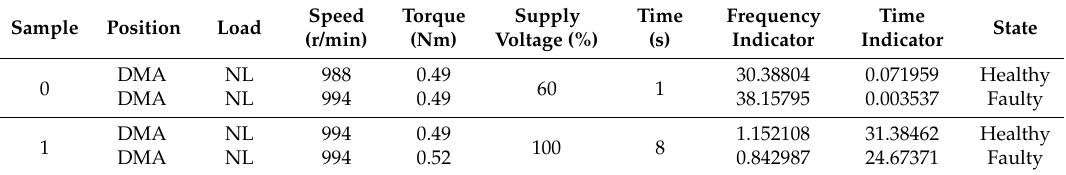
Table 14. Results of the time and frequency indicators for the DMA